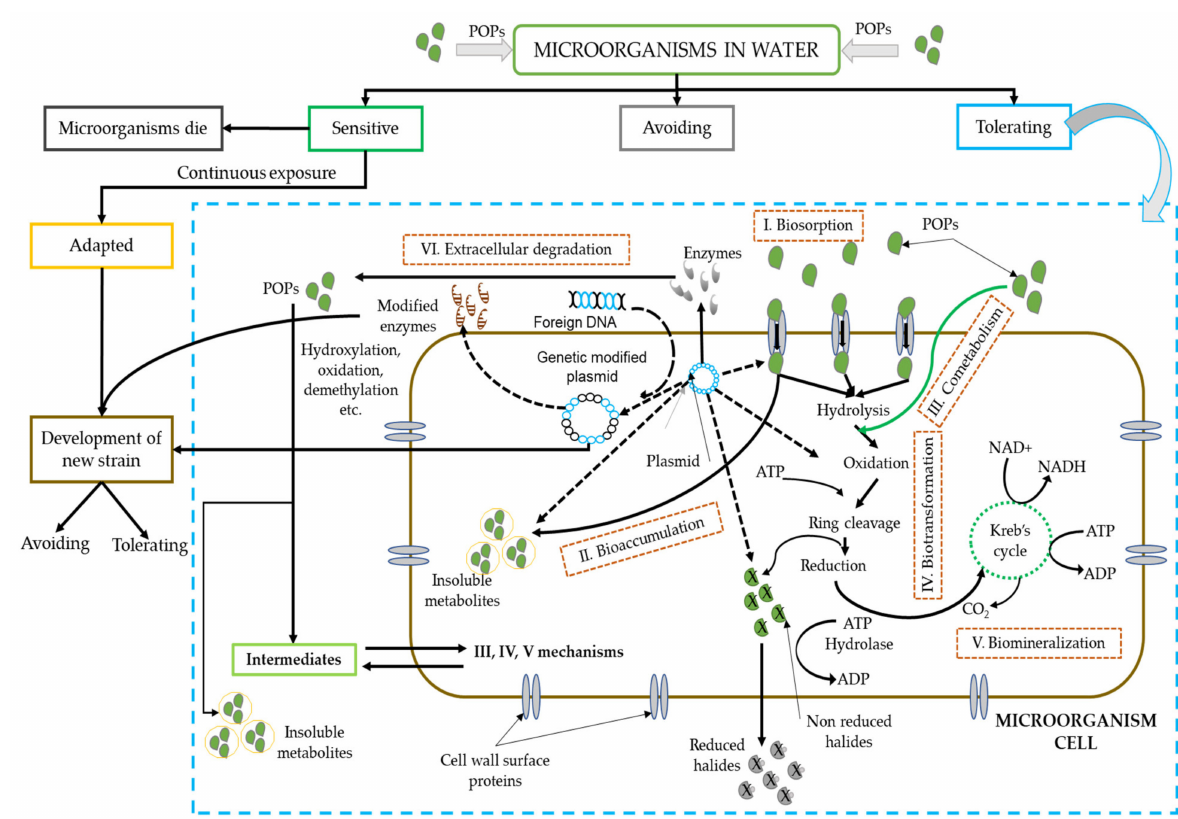
Figure 7. POPs removal strategy followed by microorganisms: the bioremediation mechanisms followed during the interaction between microorganism cell and